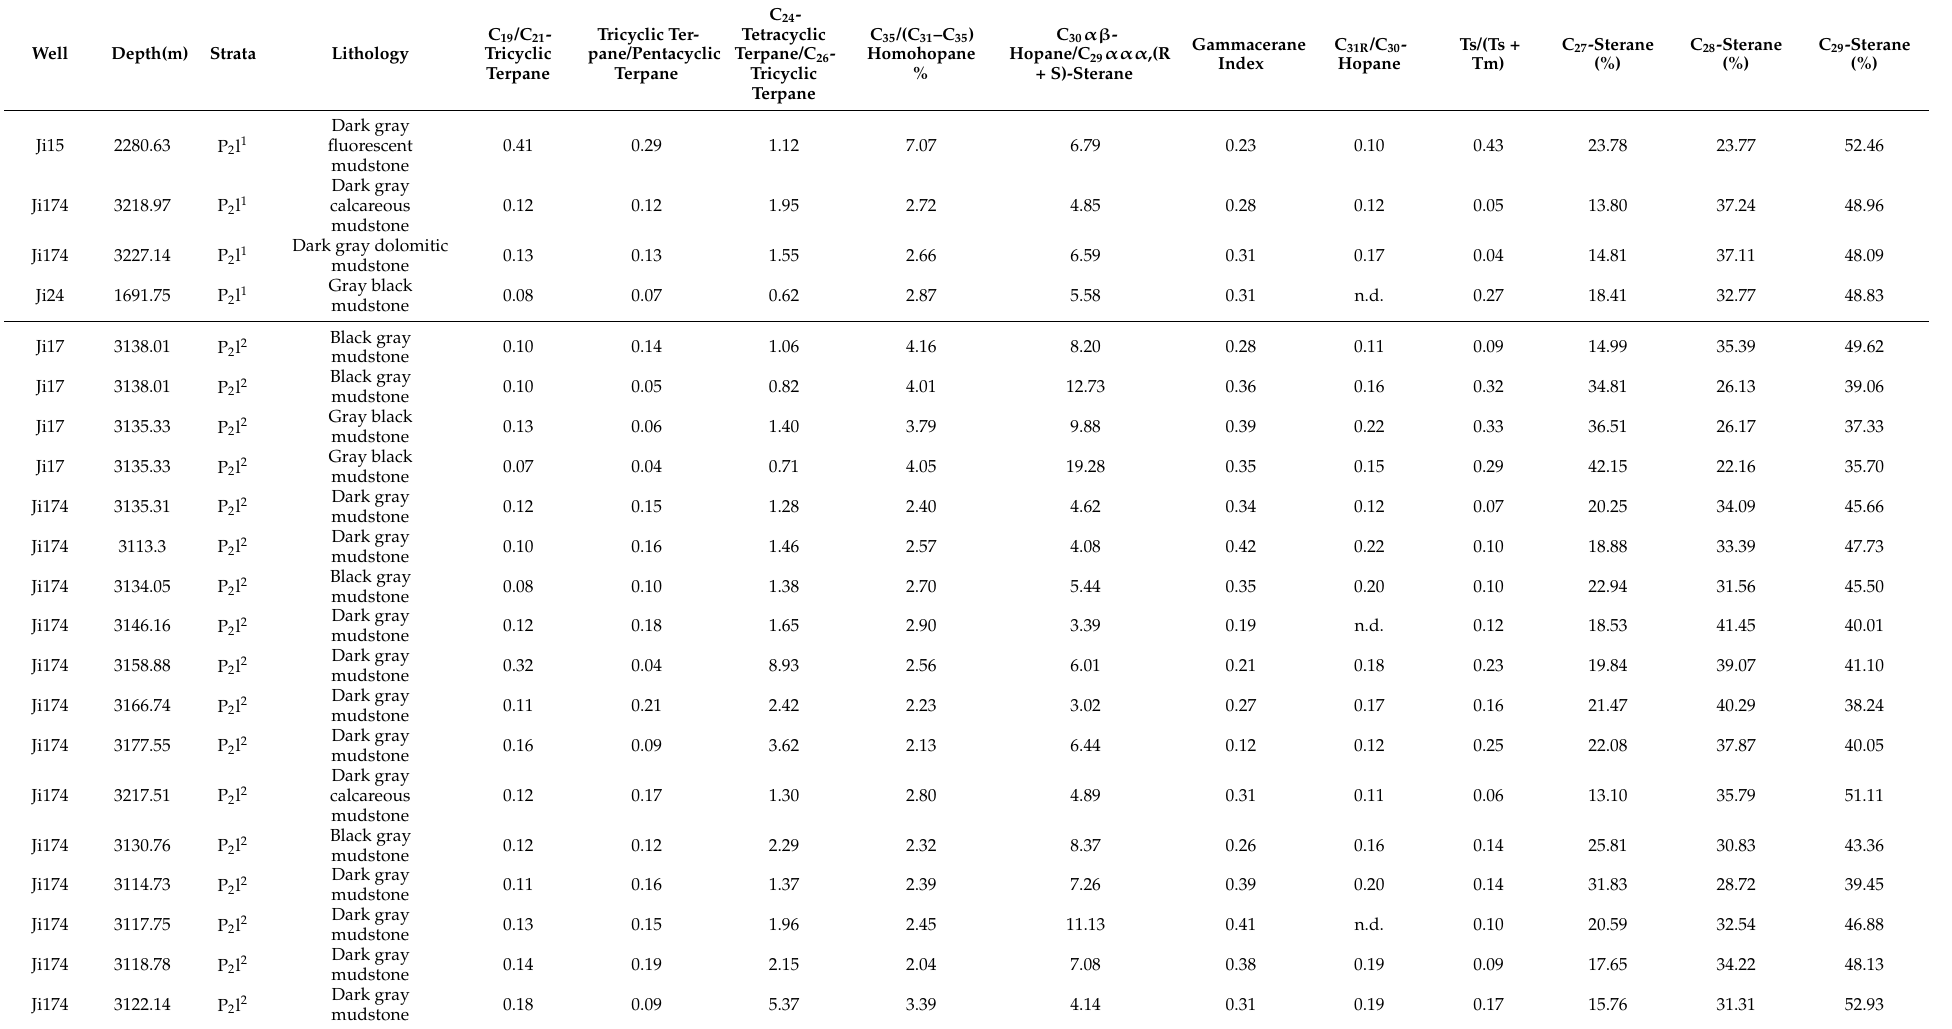
Table 1. Biomarker fingerprints of P 2 l shale in the Jimsar